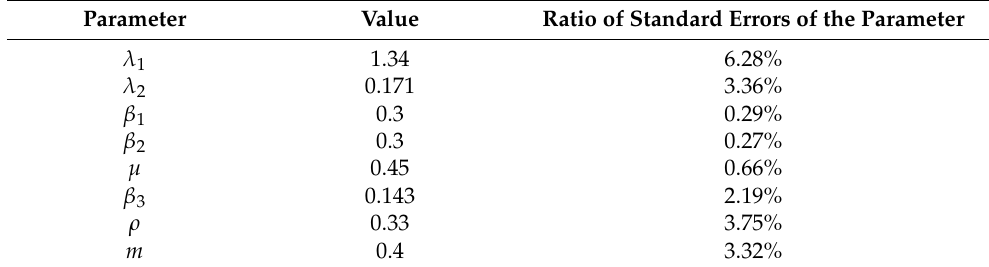
Table 9. Model estimated parameter